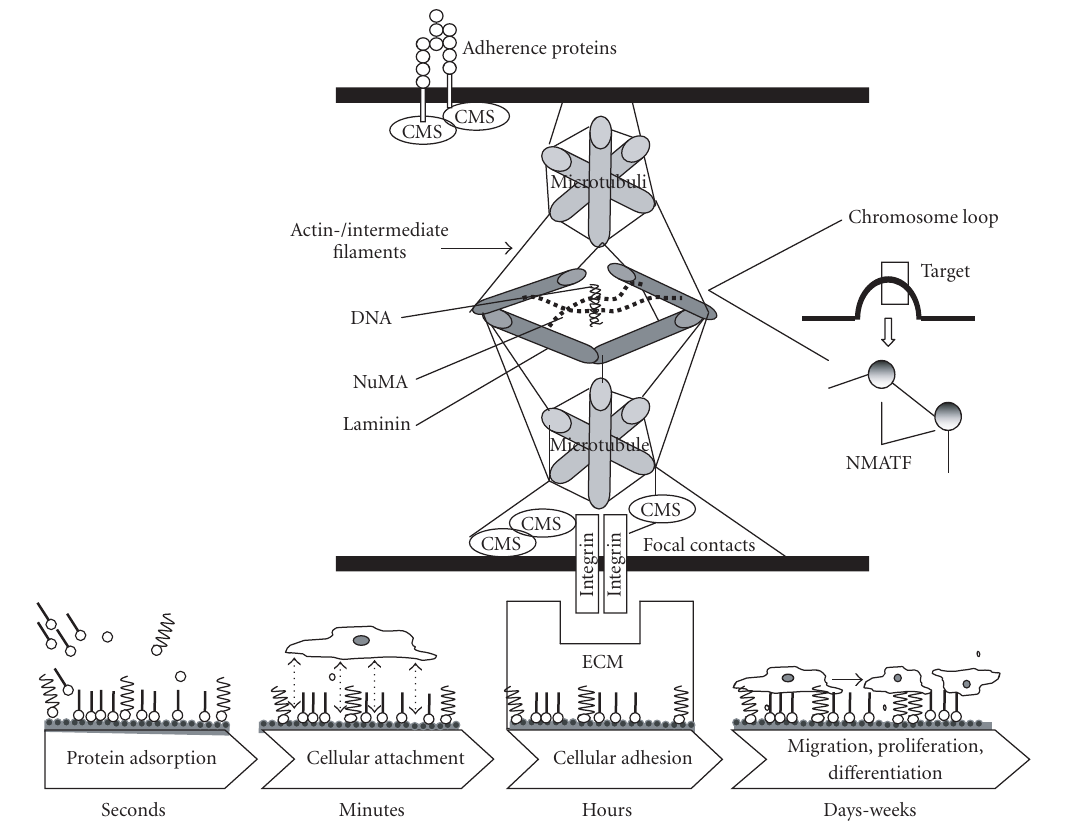
Figure 2: The scheme shows principal interactions of extracellular matrix (ECM) proteins and adjacent cells [39–41]. Interlinking proteins, focal adhesion proteins (predominantly integrins), adherence junctions, the cytoskeleton (microtubuli, actin- and intermediate filaments), and the nuclear matrix, characterized by laminin and NuMA are involved to connect the cyto- and the nucleoskeleton with the ECM [42]. Here, especially the heterodimeric integrins can act as molecular bridges between adsorbed ECM proteins of a biomaterial and interacting cells [43–45]. Several proteins of the connective membrane skeleton (CMS) such as p130 cas , zyxin, moesin, paxiliin, fembrin, VASP are con- nected to the nucleus by focal adhesion proteins and act as signal transducers. These proteins are potent to transfer information from the cell membrane to the intracellular space and control the conformation and activity of gene promotors via nuclear matrix architectural transcrip- tion factors (NMATF). Integrins also play a crucial role in transduction of cytomechanical forces from ECM proteins to the cytoskeleton. In addition, cells are connected via N-cadherin, which is strongly expressed by